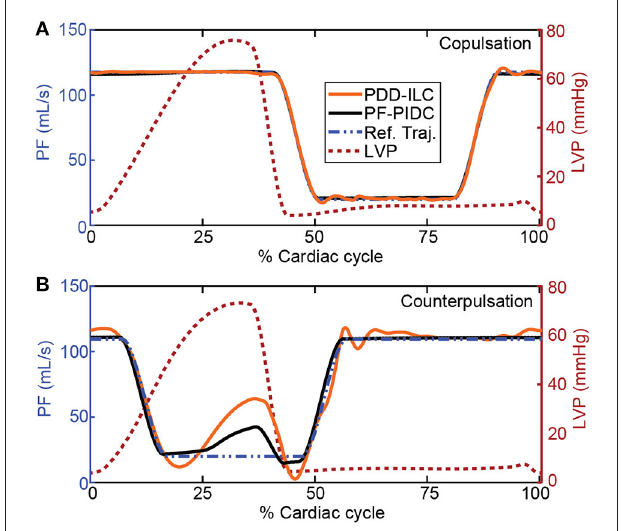
FIGURE 6 | Reference trajectory tracking performance of the PDD-ILC and the PF-PIDC during one cardiac cycle of the rest-conditions experiment (Exp0, Supplementary Table S1 , Supplementary Material ) under (A) copulsation and (B) counterpulsation. The reference trajectories, along with the left ventricular pressure profile that corresponds to the main source of disturbance are given for both modes. Both controllers are able to track accurately the reference trajectory during copulsation, reaching the maximum and minimum PF values without time lag. During the counterpulsation, the high disturbance of the fast change in LVP cannot be compensated completely from any of the controllers, however, the overall tracking is adequate. PDD-ILC, physiologic data-driven iterative learning controller; PF-PIDC, pump flow proportional-integral-derivative controller; Ref. Traj., reference trajectory; LVP, left ventricular